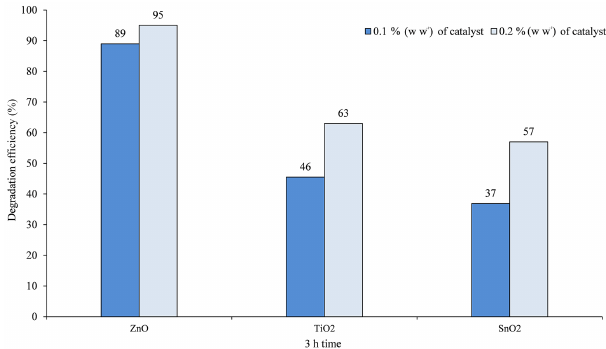
Figure 8. The impact of catalyst concentration on the efficiency of